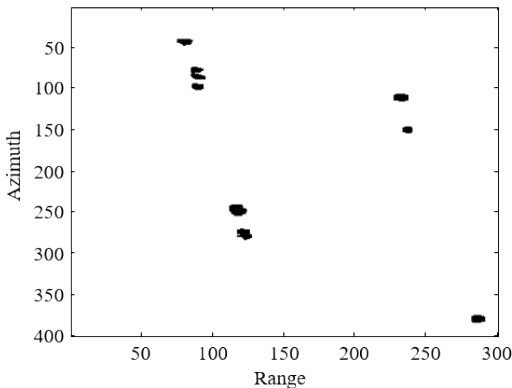
Figure 10. The ground truth